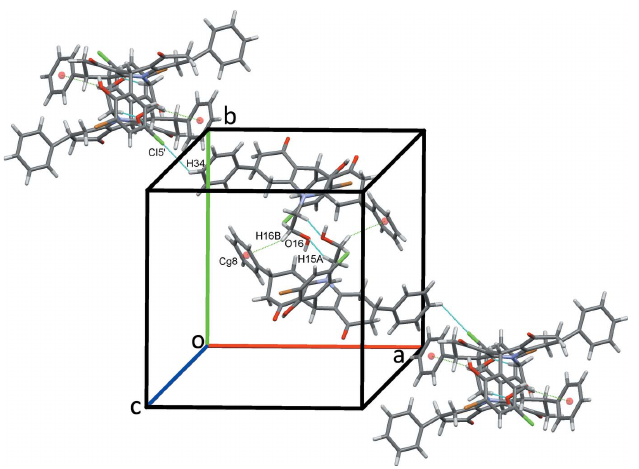
Figure 4 Double chains of molecules of (I) along the ab